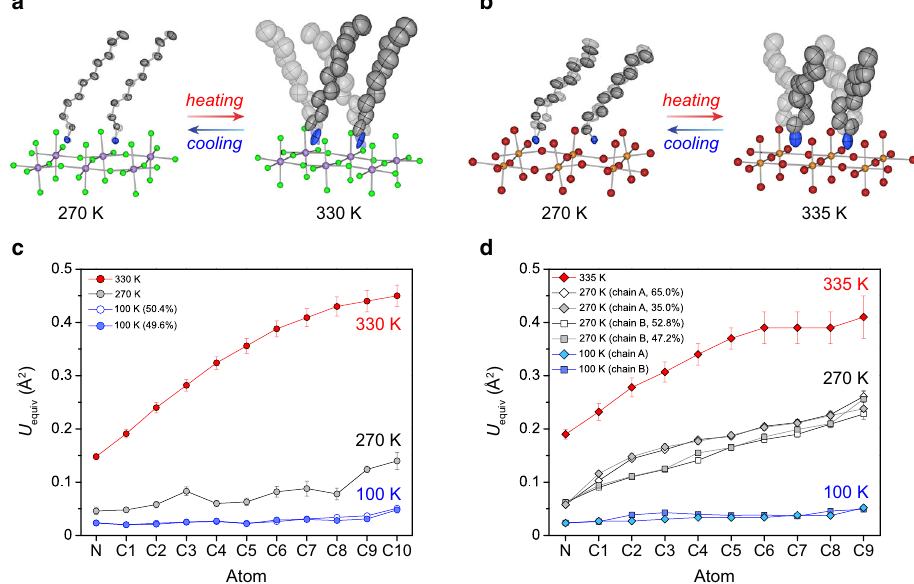
Fig. 8 Variable-temperature single-crystal structures. Conformations of the alkylammonium chains in the LT and HT phases of ( a ) (DA) 2 MnCl 4 and ( b ) (NA) 2 CuBr 4 , with atomic displacement parameters shown at 50% probability for the C and N atoms of the alkylammonium chains. In the LT phase, decylammonium (DA) chains in (DA) 2 MnCl 4 display one conformation, with a single gauche C – C bond (C2 – C3), while nonylammonium (NA) chains in (NA) 2 CuBr 4 adopt two conformations, alternating between chains with a gauche C1 – C2 bond (chain A) and those with a gauche C2 – C3 bond (chain B). Purple, orange, green, brown, gray, and blue spheres represent Mn, Cu, Cl, Br, C, and N atoms, respectively. H atoms are omitted for clarity. Note that DA chains are disordered over a special position in both the LT and HT phases, while NA chains are modeled with two-part disorder in the LT phase and disordered over a special position in the HT phase. Temperature dependence of U equiv (equivalent isotropic displacement parameters) is shown for alkylammonium cations in ( c ) (DA) 2 MnCl 4 and ( d ) (NA) 2 CuBr 4 , at 100 K, 270 K (LT phase), and 330/335 K (HT phase). Error bars represent standard the phase transition in (NA) 2 CuBr 4 to be more sensitive to pressure, which reduces the minimum pressure required to overcome hysteresis and induce a reversible phase transition.